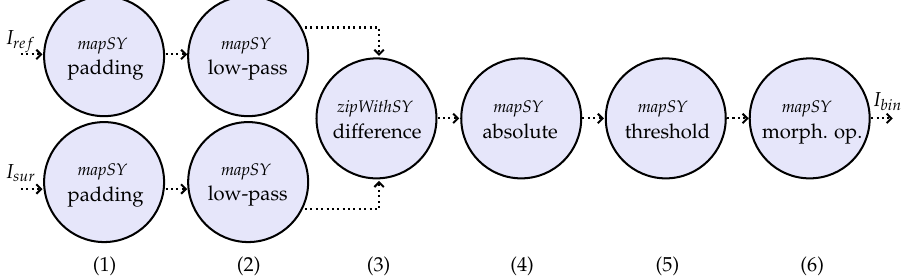
Figure 3. ForSyDe model for the change detection algorithm using the synchronous model of computation. In ( 1 ), the tiles are padded to allow the application of the low-pass filter in ( 2 ). Then, the resulting values of the reference image are subtracted from the values of the surveillance image in ( 3 ). In ( 4 ), the absolute values of the pixels are calculated, and in the sequence, one threshold operation is performed (with the value τ 3 ) in ( 5 ). Morphological operations are performed in ( 6